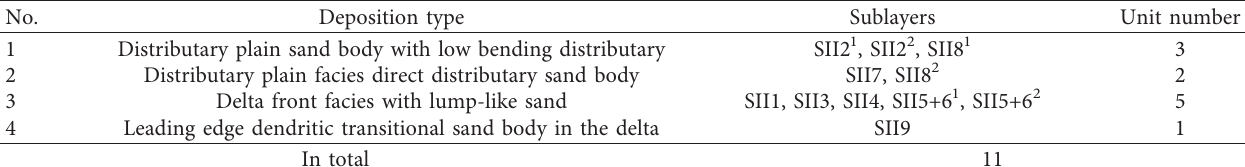
Figure 6: B-1-D and B-2-X location in Daqing [40]. Table 7: B-1-D sediment unit [72].